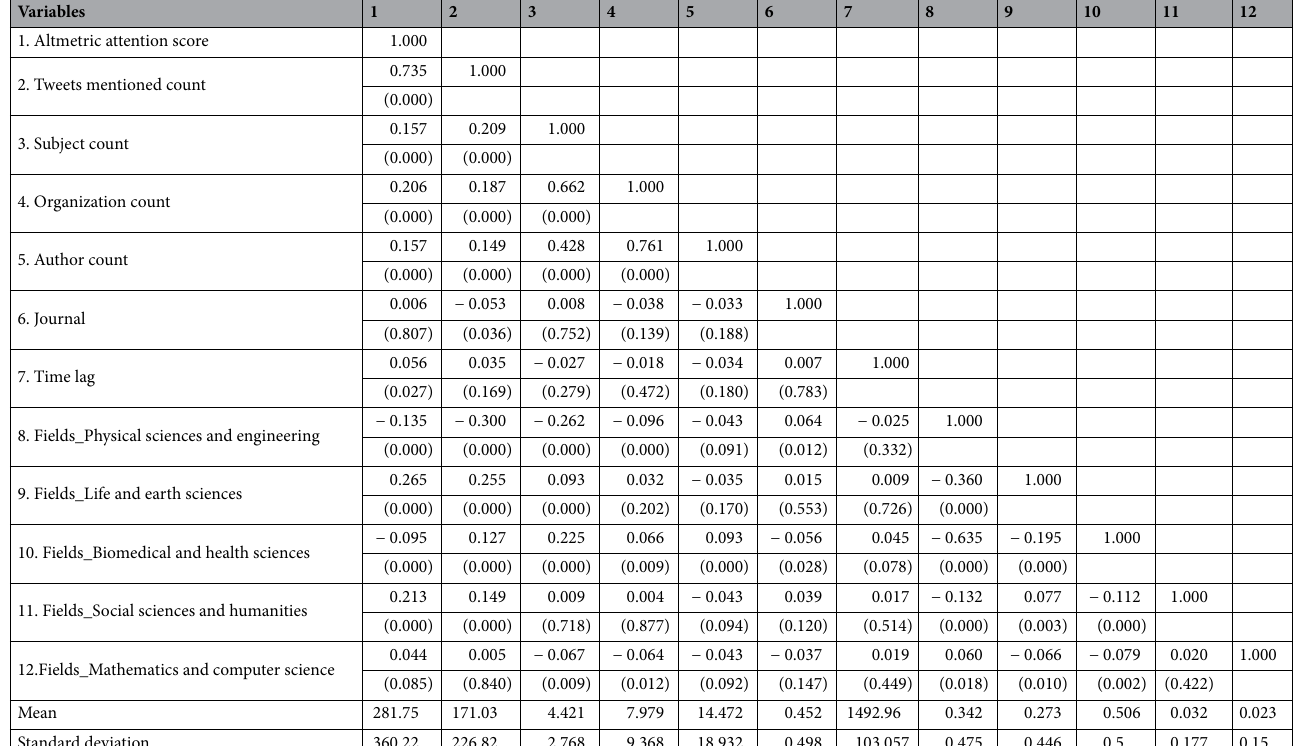
Table 1. Descriptive statistics and correlation coefficients. P-value are in parentheses. Journal and all fields are both dummy